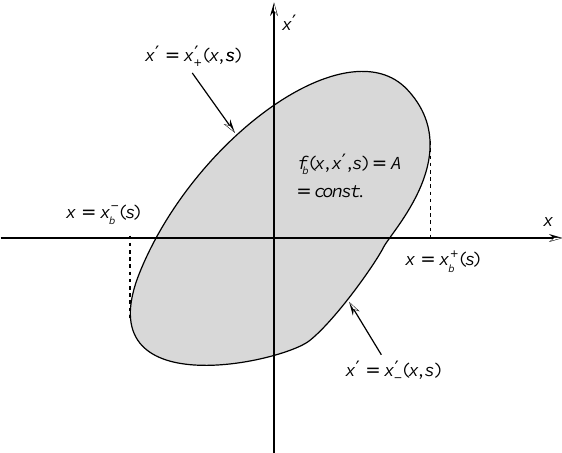
FIG. 1. Phase-space plot of distribution function with uni- form phase-space density f b (cid:1) x , x 0 , s (cid:2) (cid:1) A (cid:1) const in the region (cid:1) x , s (cid:2) and x 2 (cid:1) s (cid:2) , x , x 1 (cid:1) s (cid:2) [Eq. (cid:1) x , s (cid:2) , x 0 , x 0 x 0 b b 2 1